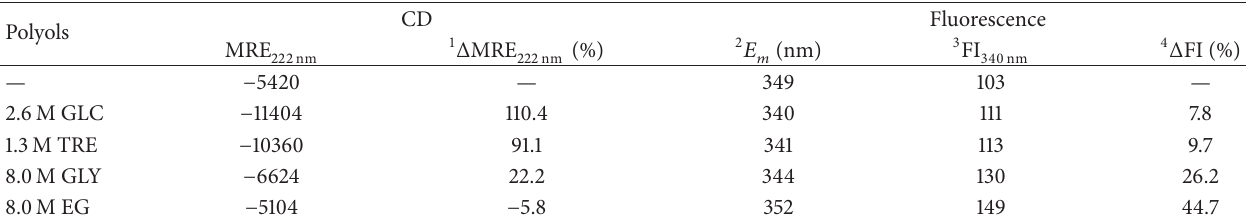
1 Δ MRE 222 nm represents percentage change in the MRE 222 nm in the presence of polyols. Negative sign shows the decrease. 2 𝐸 𝑚 = Emission maxima. 3 FI 340nm = Fluorescence intensity at 340nm. 4 Δ FI = Percentage change in the fluorescence intensity in the presence of polyols.